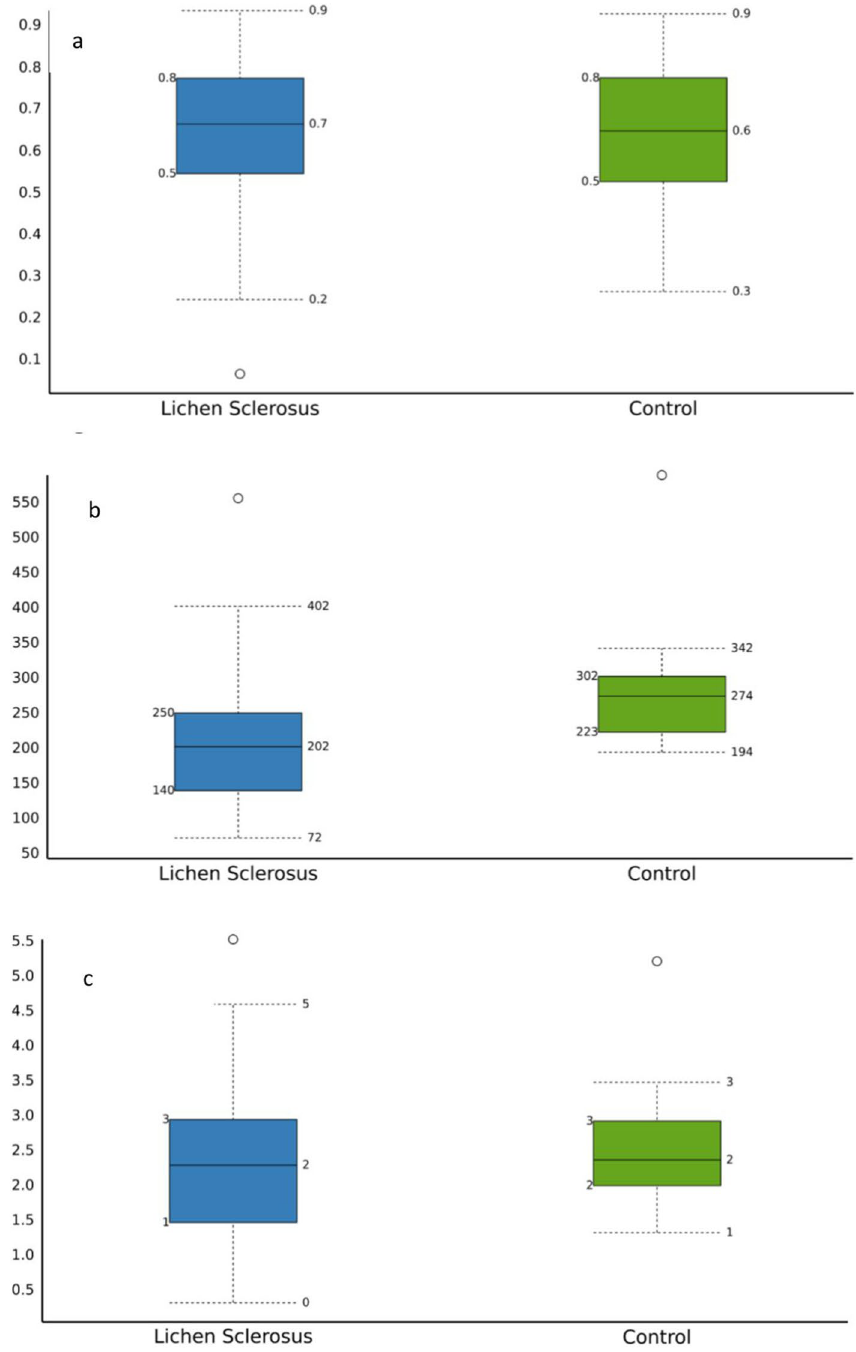
Figure 1. Microbial alpha diversity in LS and control patients. Wilcoxon rank sum testing found no significant difference by either method ( a) Simpson, ( b) Chao1, ( c) Shannon alpha diversity